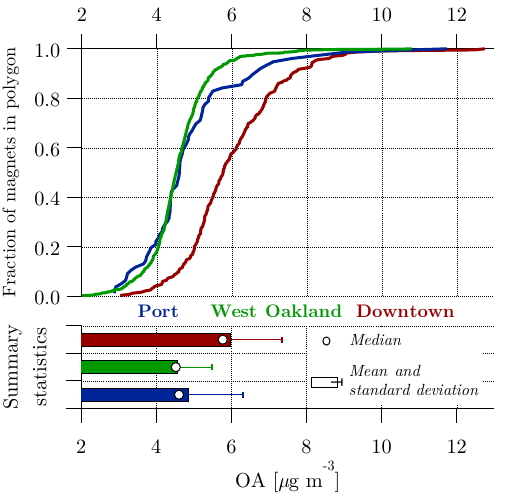
Figure 3. Cumulative distributions, mean, and median of OA con- centrations in Port, West Oakland, and